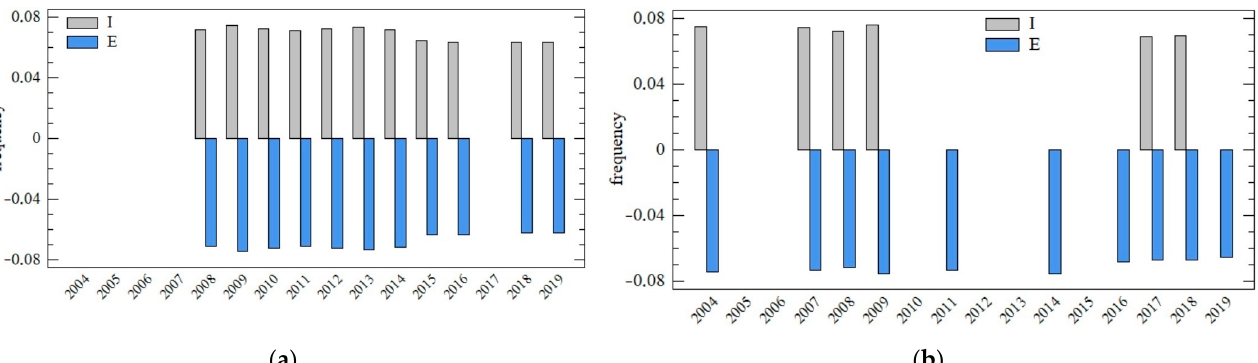
Figure 7. Development of the regressor in the regression function RCR = (a × ln(I)) 2 depending on the legal form in the period 2004–2019: ( a ) cooperatives; ( b ) non-cooperatives.